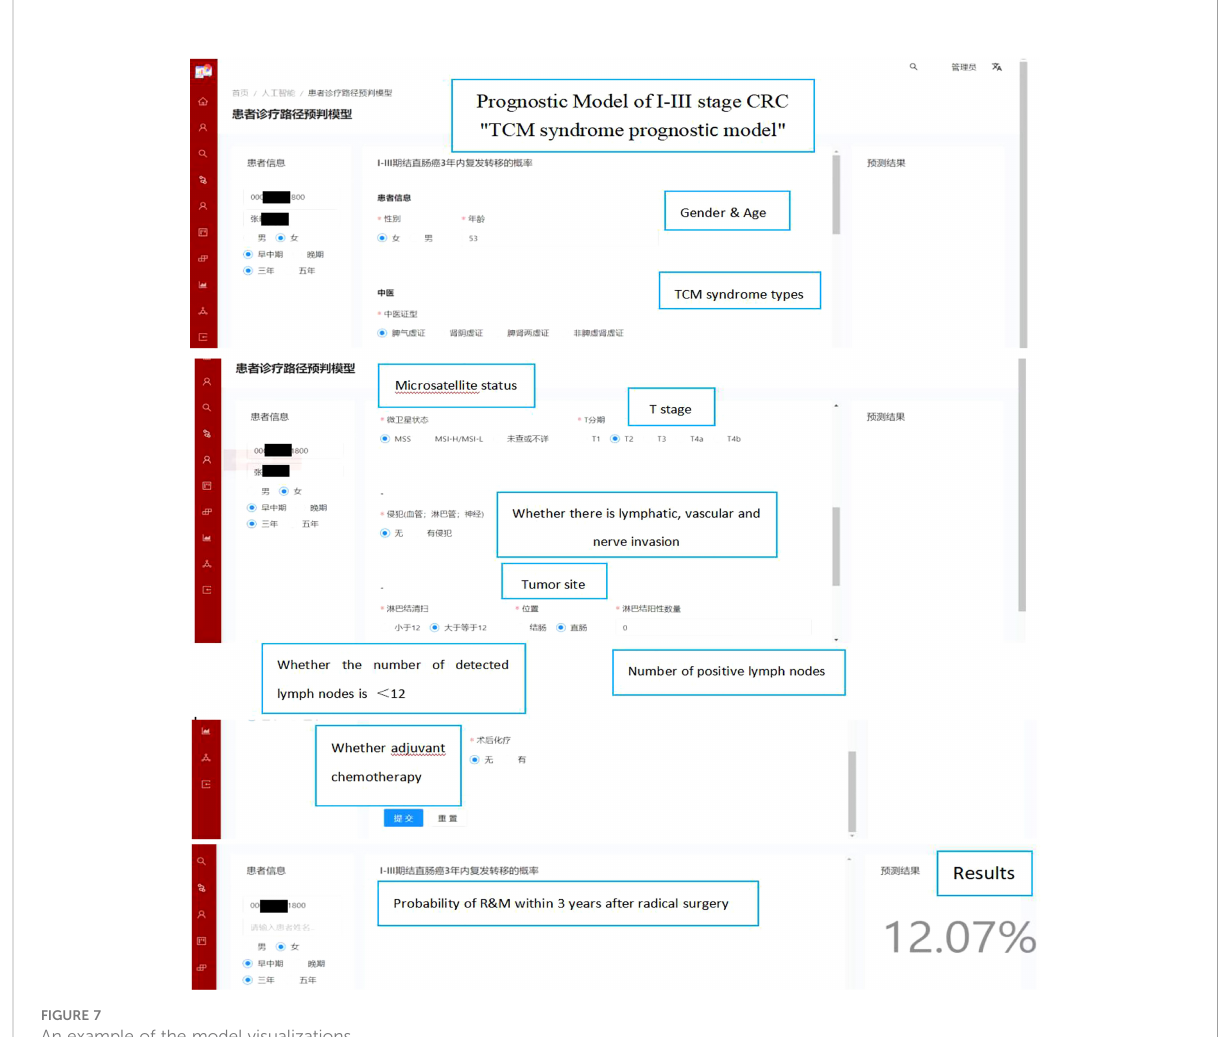
FIGURE 7 An example of the model